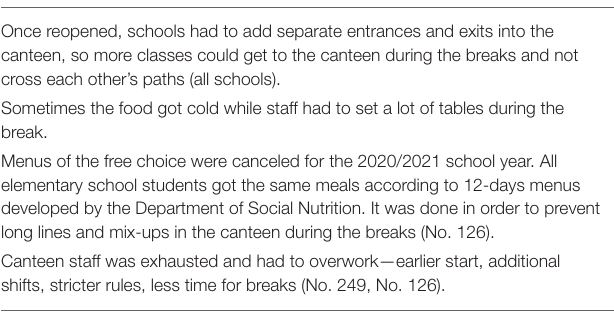
cross each other’s paths (all